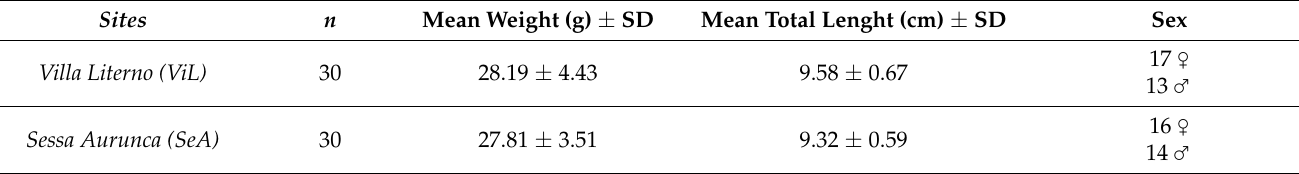
Figure 1. Map showing locations of the sampling sites: Villa Literno (ViL) and Sessa Aurunca (SeA). Table 1. Number of individuals (n), weight (g), size (mm) and sex of Procambarus clarkii captured at Villa Literno and Sessa Aurunca.